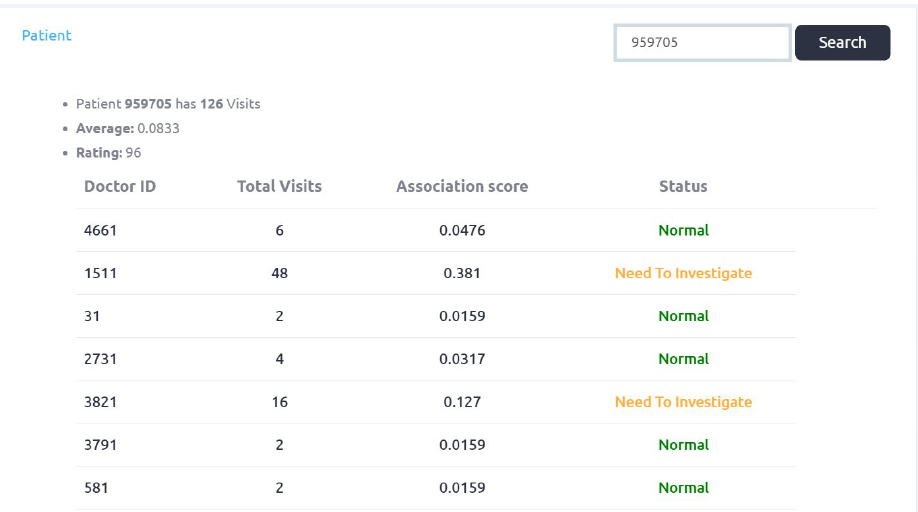
Figure 11. Patient with respect to doctor association